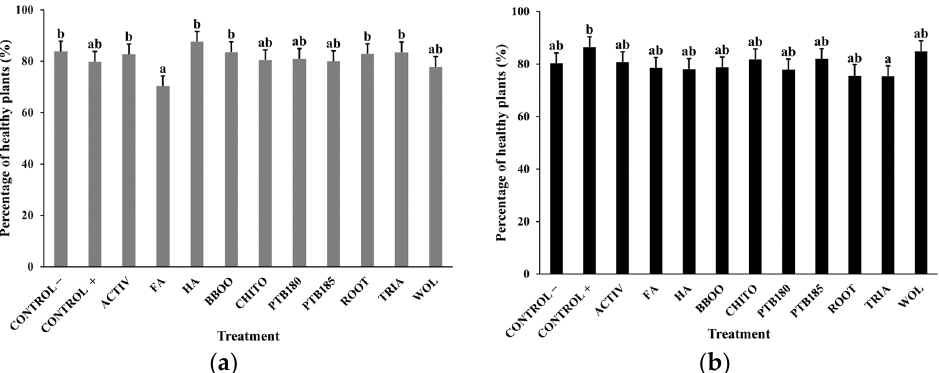
Figure 2. Effect of biostimulants on the percentage of healthy baby leaf lettuce plants grown in a substrate inoculated with Pythium ultimum under organic ( a ) and conventional ( b ) management. Substrate was drenched with Ascophyllum nodosum extract (ACTIV), fulvic acid (FA), humic acid (HA), bamboo vinegar (BBOO), chitosan (CHITO), Bacillus pumilus PTB180 (PTB180), Bacillus subtilis PTB185 (PTB185), Trichoderma harzianum T-22 (ROOT), triacontanol (TRIA), or wollastonite (WOL). Control seeds were sown in a substrate that was drenched with water (no biostimulants) and inoculated with P. ultimum (CONTROL+) or non-inoculated with P. ultimum (CONTROL − ). Each value represents the mean of 8 replicates ± standard error. The means sharing a same letter are not significantly different according to Fisher’s protected LSD test ( p ≤ 0.05).